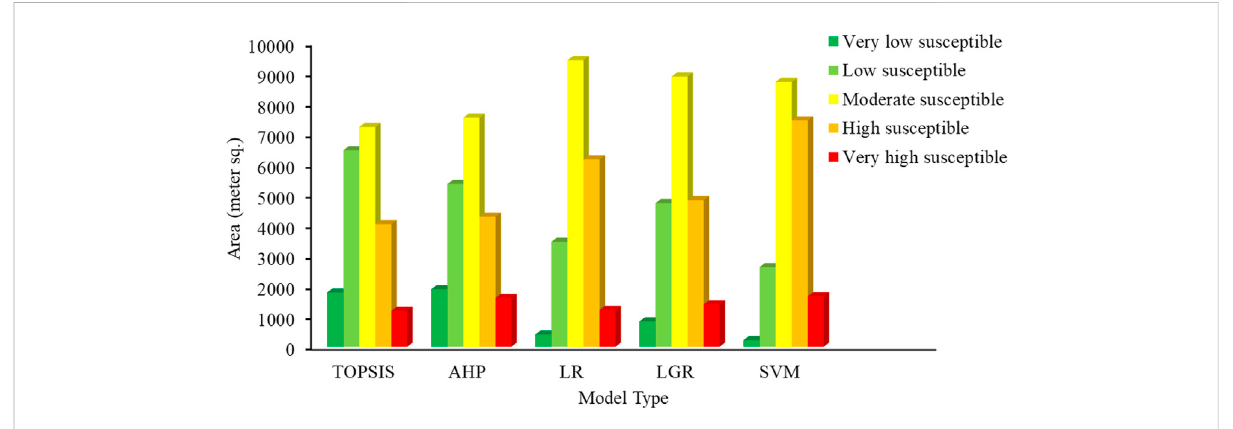
FIGURE 6 Landslide susceptibility class division in terms of area for different